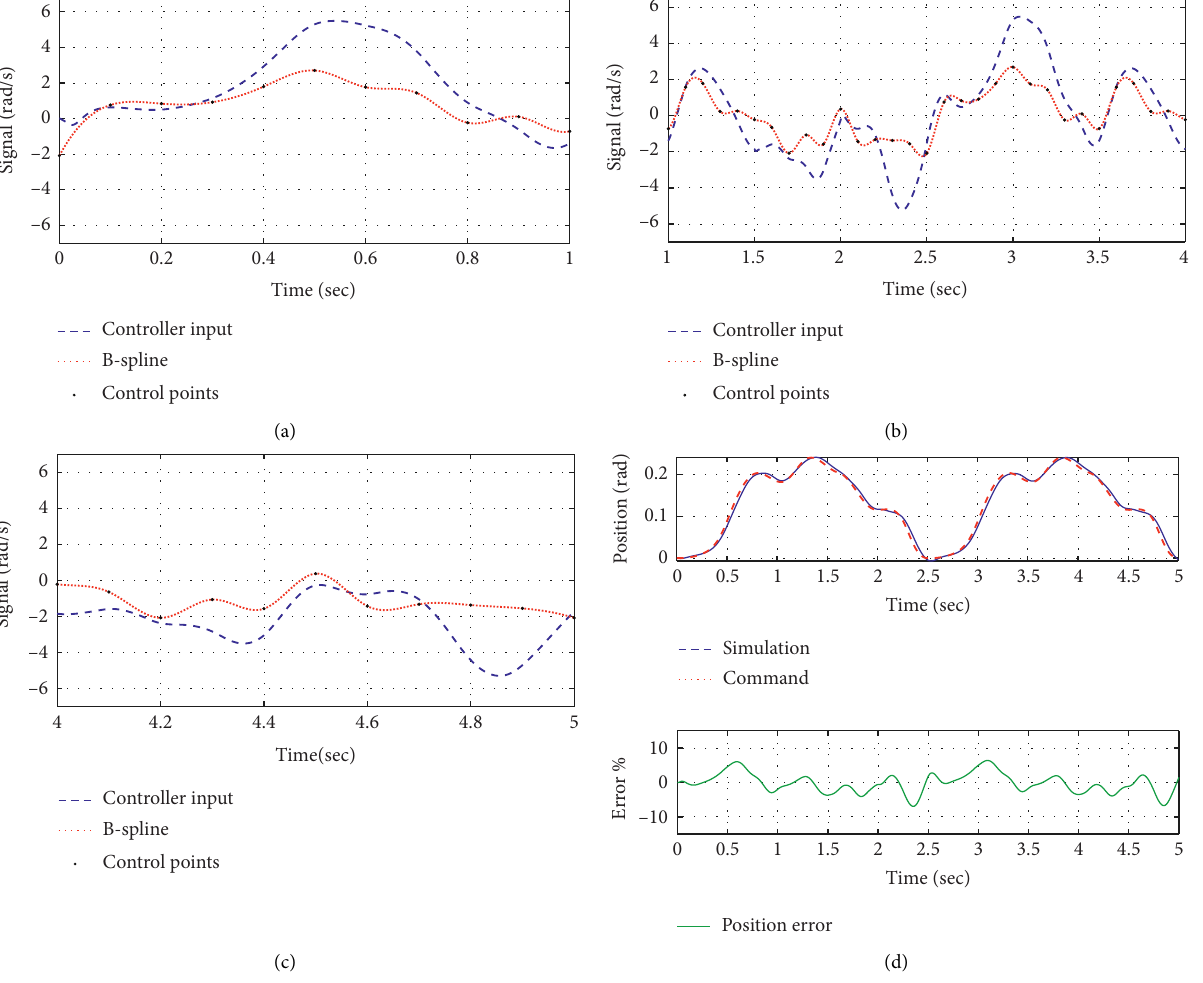
Figure 5: Input modification scheme of manipulator controller based on conventional B-spline optimization. (a) Controller input and compensator output in part 1. (b) Controller input and compensator output in part 2. (c) Controller input and compensator output in part 3. (d) Comparison and error of reference position and measurement